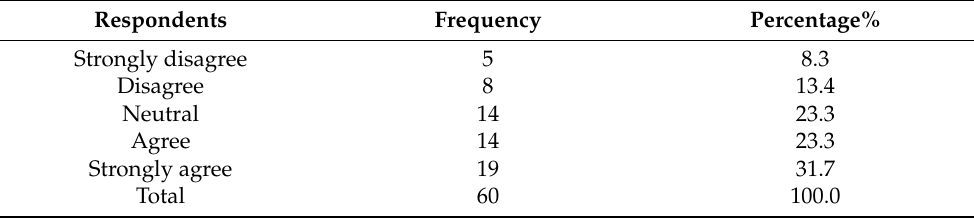
Table 9. In our business, the CEO’s function is independent from the chairman’s role.